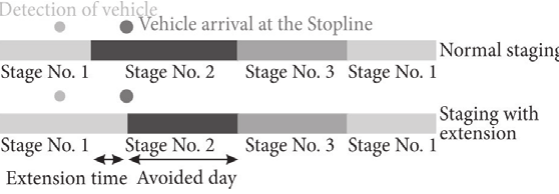
Fig. 2. Green time extension